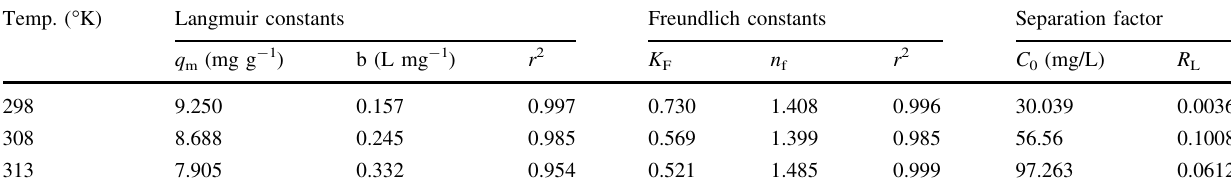
Fig. 2 Effect of biomass particle size using A. heterophylla at temp 30 (cid:3) C, pH 4.5 and C T 30.039 mg L - 1 ( a ), effect of temperature at biomass weight 20 g L - 1 and pH 5.5 ( b ), Langmuir plots at various Table 1 Langmuir and Freundlich isotherm model parameters for Cd(II) biosorption on A. heterophylla Temp. ( (cid:3) K)